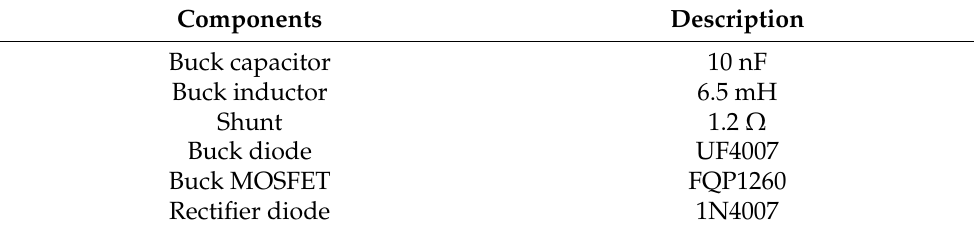
Table 2. Components used to implement the PFC buck converter with IC FL7701.